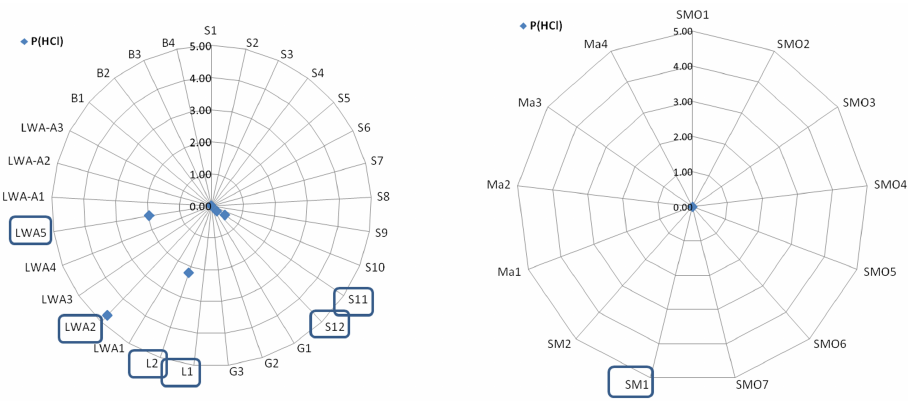
Figure 5. Substrate components and substrates below the limit [33] for P (mg / kg).